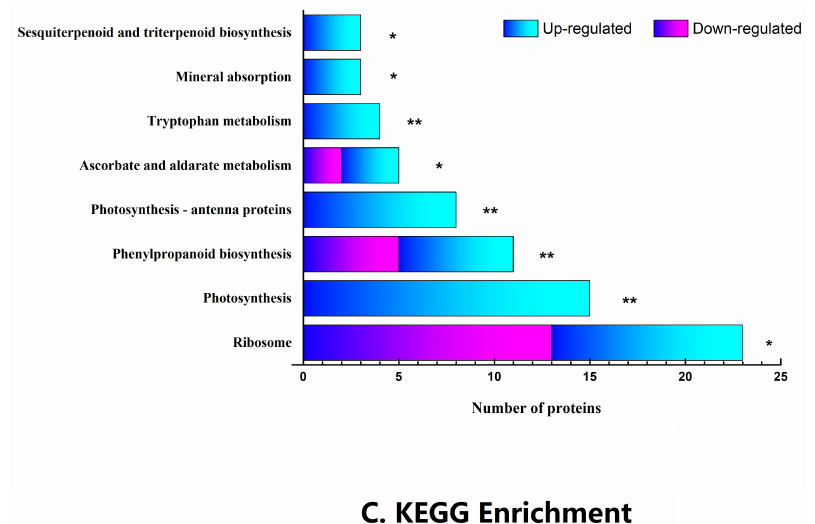
Figure 6. Metabolic analysis of KEGG pathway (matched number more than four) and KEGG